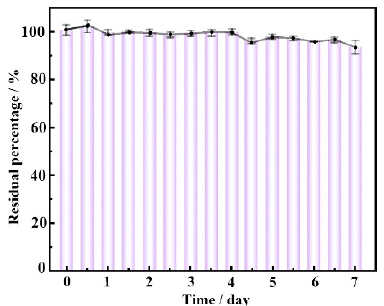
6 of 10 Table 1. Comparison of Different Methods for DM Analysis. Method